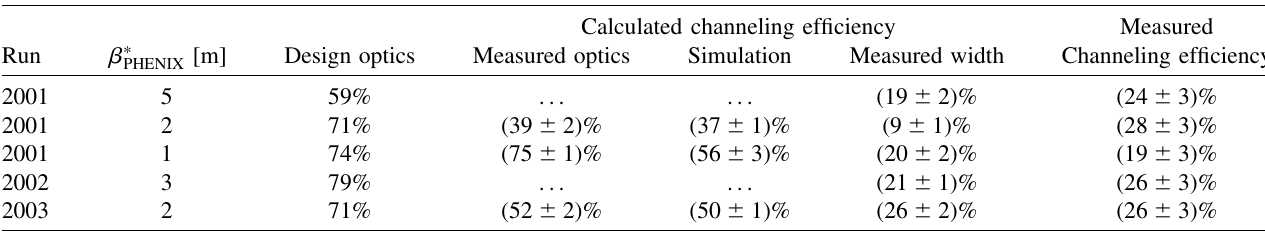
TABLE V. Comparison among various models of expected channeling